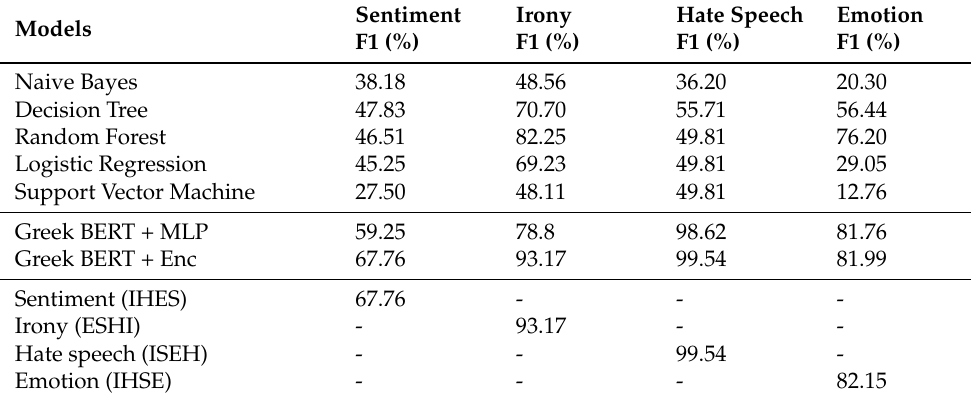
Table 6. Baseline experimental results